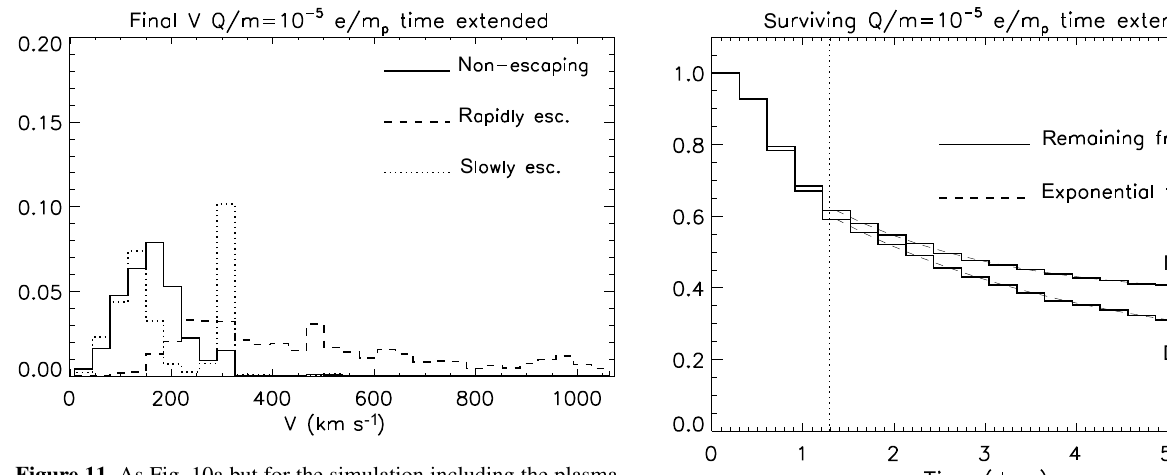
Figure 11. As Fig. 10a but for the simulation including the plasma ion drag.